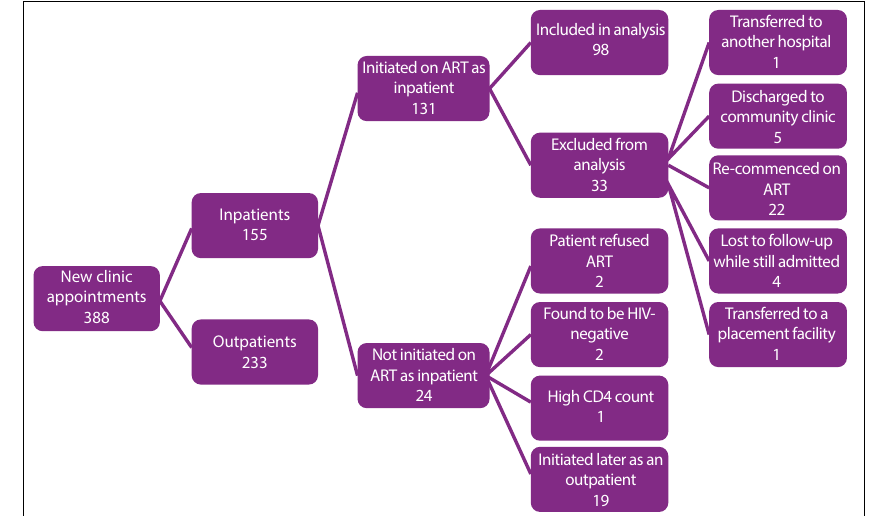
Fig. 1. Flow chart outlining all new patient clinic appointments at the Luthando Neuropsychiatric Clinic for